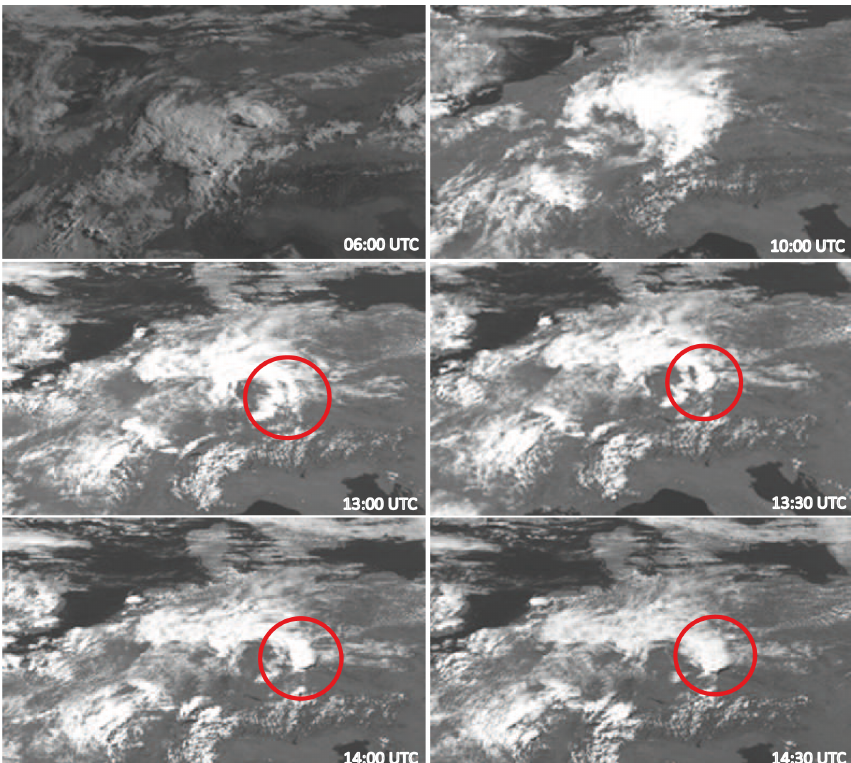
Figure 3. Temporal evolution (06:00, 10:00, 13:00, 13:30, 14:00 and 14:30UTC from top to bottom) of the MCS over Germany observed from Meteosat, obtained from the High-Resolution Visible (HRV)